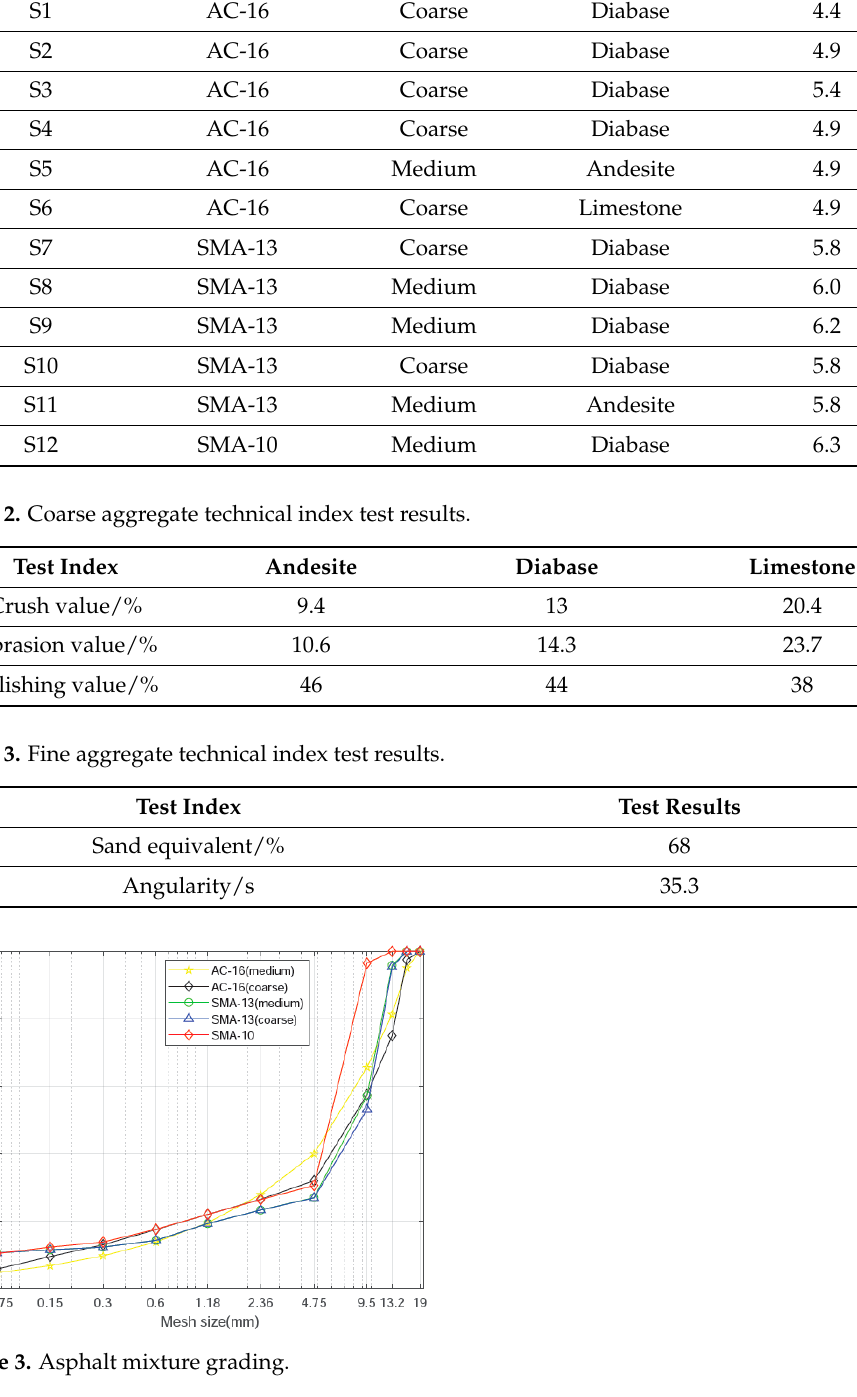
Table 3. Fine aggregate technical index test